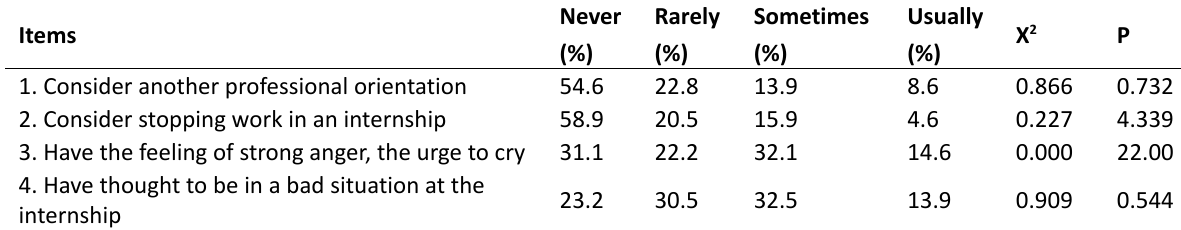
Table 4. Correlations between the CT theoretical knowledge and the PE-ST attractiveness Items